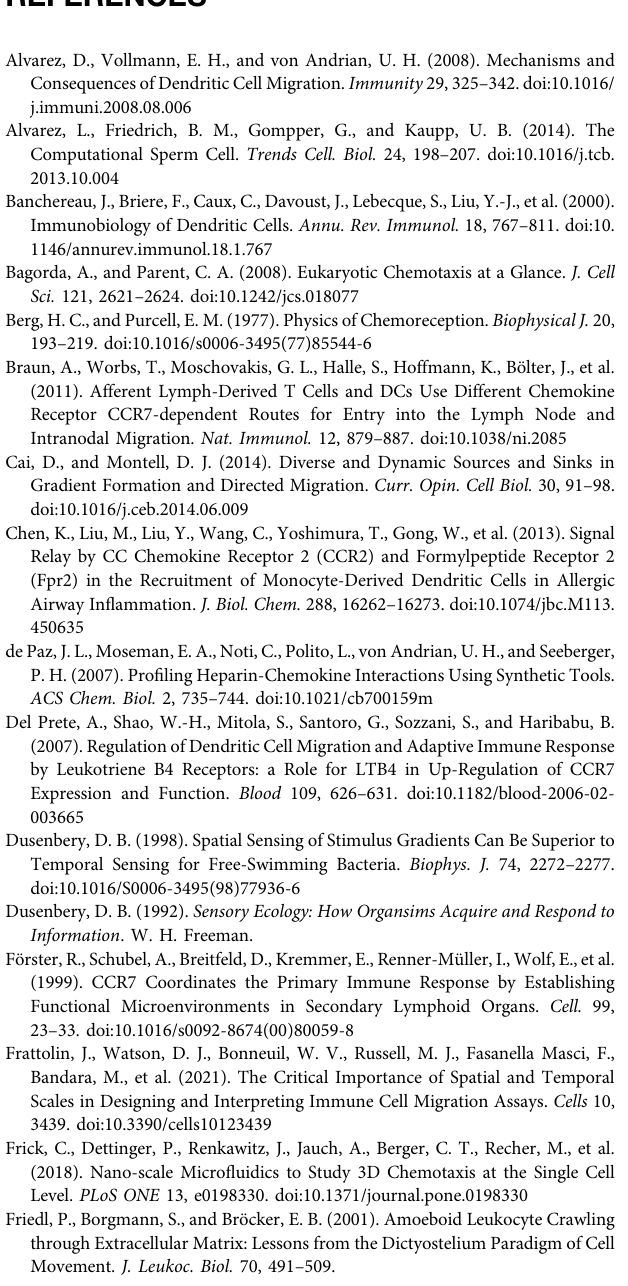
mark trajectories of motile cells following manual tracking. Images were acquired every 2 s. Period of time, 56 min. Supplementary Video S5 | Steady-state chemokine gradients are essential to stabilize leading edge protrusions in BM-DCs. Actin-dynamics and leading- edge polarization of a Lifeact-EGFP expressing BM-DC (gray) in a stable soluble CCL19 gradient and subsequent depolarization of the cell in response to CCL19 gradient removal. Instant time of gradient removal: 2.5 min following start of the video. Images were acquired every 2 s. Period of time, 5 min. Supplementary Video S6 | Chemotaxing BM-DCs sense and response to 180- degree direction switching of soluble CCL19 gradients and instantaneously